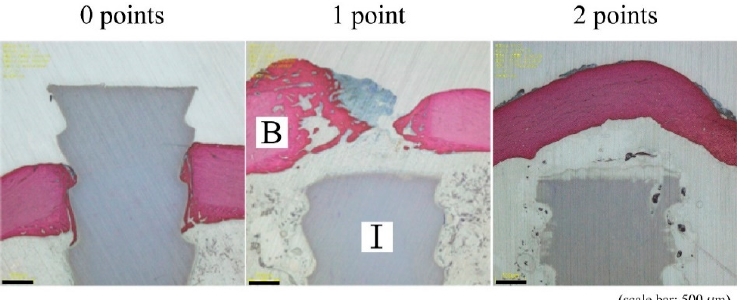
Figure 3. Histological scores for bone bridging above implant by modified Garcia scoring [12]. The point of 0 indicated no bone bridging or only fibrous tissue bridging, 1 indicated cartilage or slight bone bridging, and 2 indicated complete bone bridging above the implant. B, bone; I, HA-PLLA threaded pin.